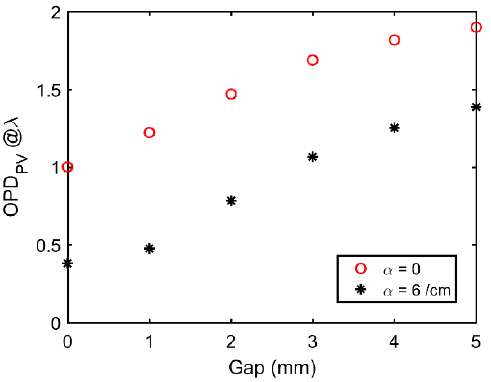
Figure 11. The P-V of the OPD for a single slab as a function of the gap between the pump area absorbing cladding layer within the laser beam area of 56 mm × 56 mm in the two designs. Nd: glass without the absorbing cladding layer (red), and Nd: glass with cladding and α = 6/cm (black).